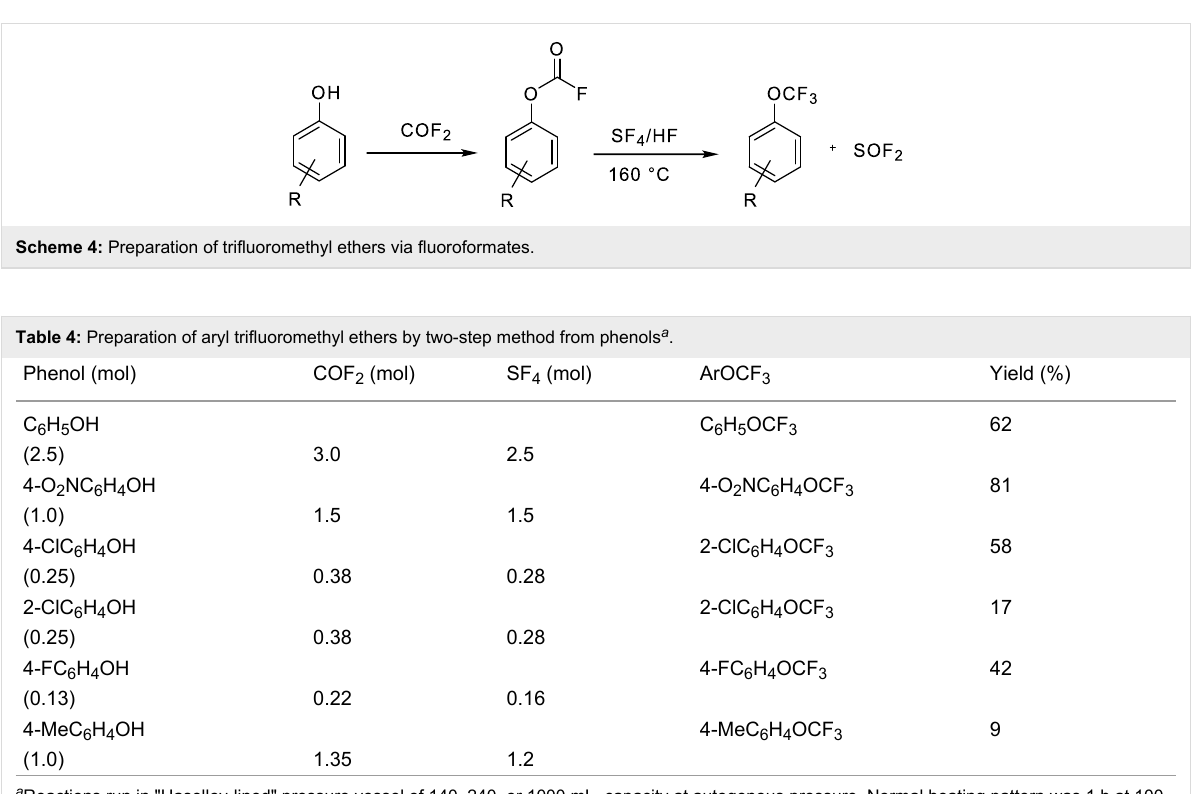
a Reactions run in "Haselloy-lined" pressure vessel of 140, 240, or 1000 mL. capacity at autogenous pressure. Normal heating pattern was 1 h at 100 °C followed by 2 to 3 h at 140 °C (or higher temperatures above phenol melting point) for the COF 2 reaction; 2 h successively at 100, 140, or 150 °C, and 160 or 175 °C for the SF 4 reaction.